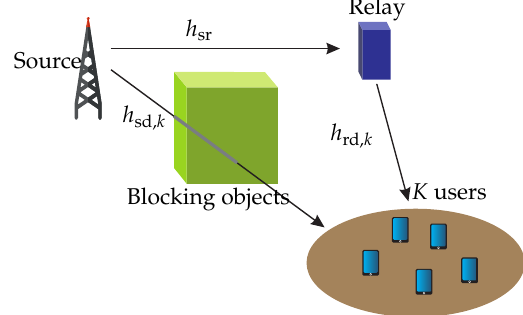
Figure 2. Relay-assisted multi-user communications.